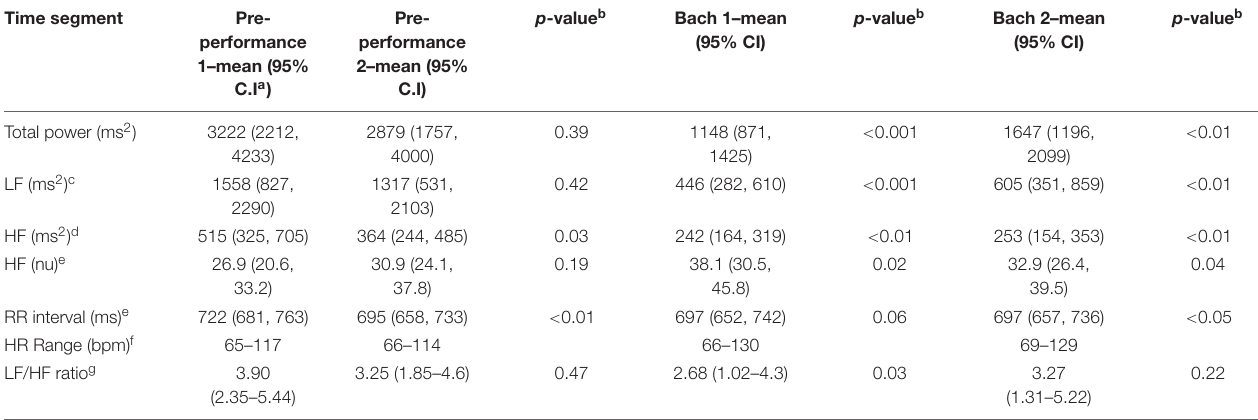
TABLE 3 | Selected Heart Rate Variability (HRV) measures during each 2.5-min segment in the pre-performance and performance phases. Time segment